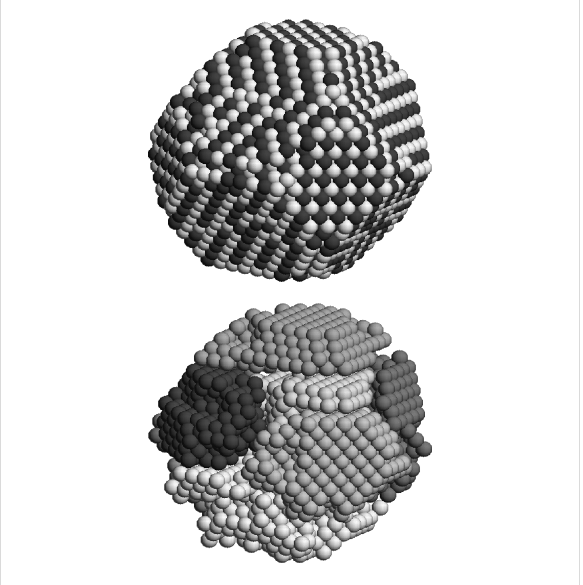
Figure 3: Structure of a free 5 nm particle after 30 s of annealing time at 1000 K. Top: Pt atoms are displayed light gray, Fe atoms dark gray. Bottom: Atoms in antiphase boundaries have been removed and the gray scale visualizes atoms that belong to the same ordered